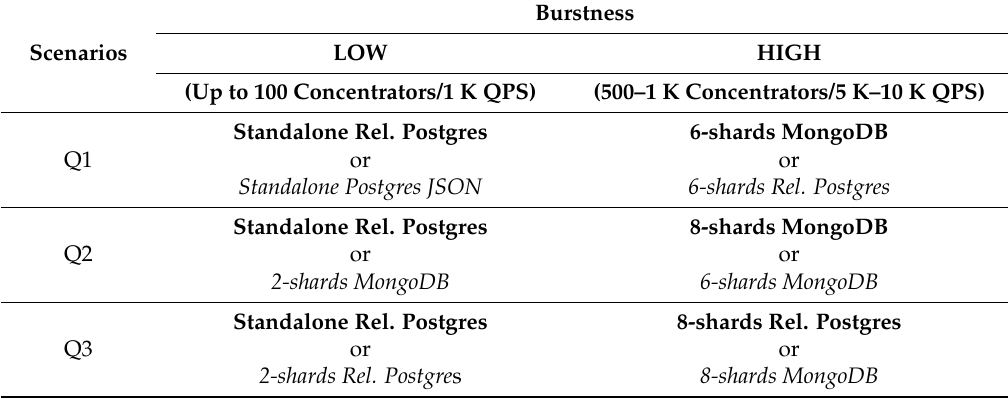
Table 5. Suggested database schemes depending on low, or high burstness categorization, where one concentrator produces 10 sensor measurements per second. The first choice is written in bold, and the second in